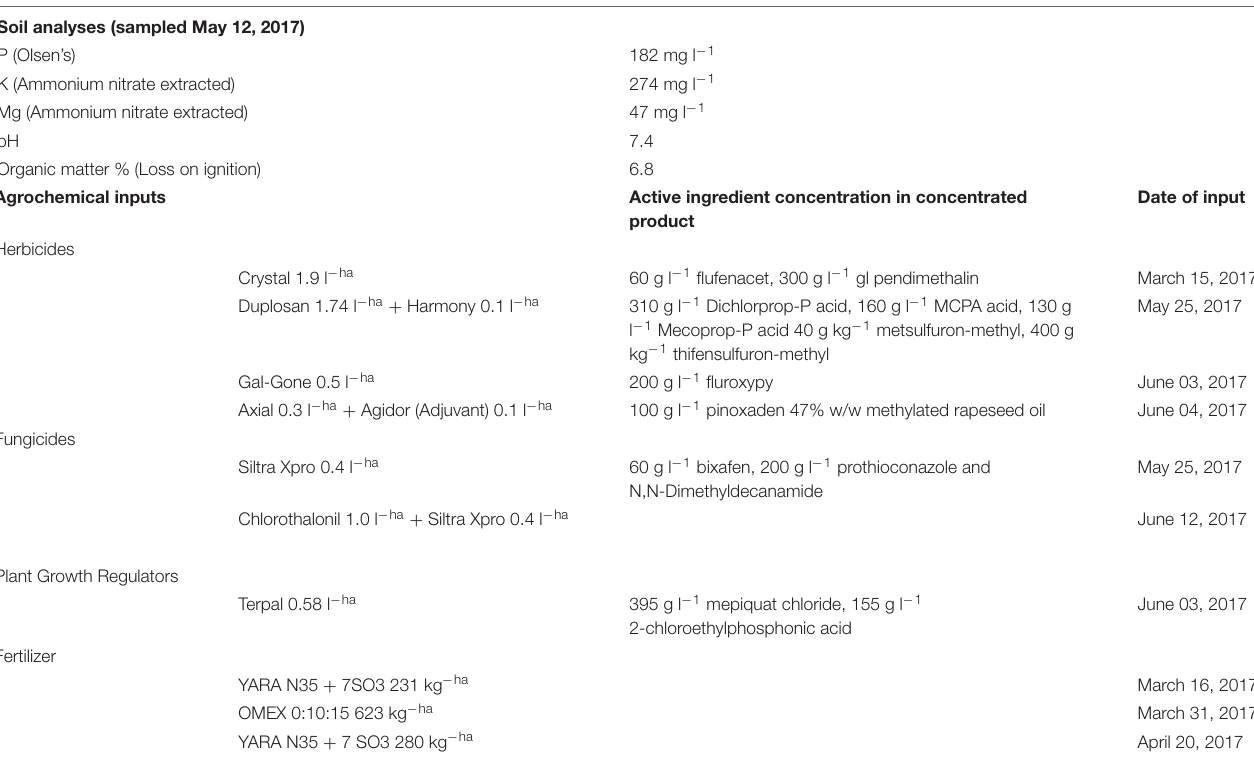
TABLE 1 | Fieldsite soil chemical analyses and agrochemical inputs used throughout the study. Soil analyses (sampled May 12, 2017)